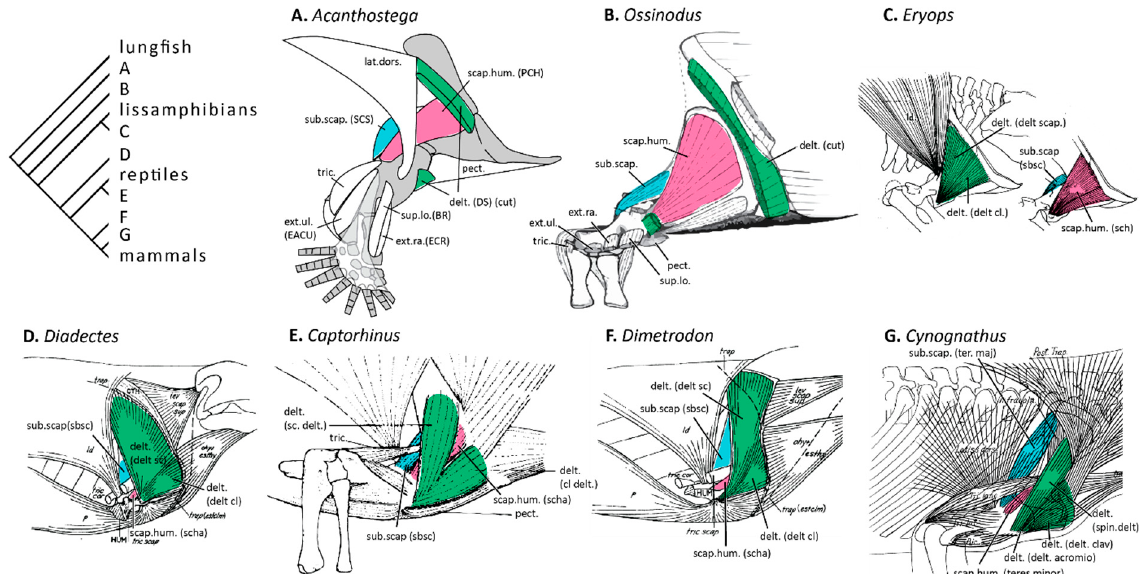
Figure 2. Evolution of the deltoid group of muscles and subcoracoscapularis in tetrapods. Reconstructions by various authors of the deltoideus (green), scapulohumeralis (pink), and subcoracoscapularis (blue) muscles. ( A ) The stem tetrapod Acanthostega , modified from Molnar et al. [10,12] (the scapular head of triceps is not shown as the authors considered its presence in stem tetrapods to be uncertain); ( B ) The stem tetrapod Ossinodus , modified from Bishop [9]; ( C ) The stem lissamphibian Eryops , modified from Miner [3]; ( D ) The stem amniote Diadectes , modified from Romer [1]; ( E ) The stem reptile Captorhinus , modified from Holmes; ( F ) The stem mammal Dimetrodon , modified from Romer [1]; and ( G ) The stem mammal Cynognathus , modified from Gregory and Camp [6]. A simplified version of the phylogeny in Figure 1 is shown on the top left. Despite different evolutionary hypotheses and different naming conventions, the muscle reconstructions are almost identical. Muscle names follow Bishop [9], with the names given in the original publications in parentheses.